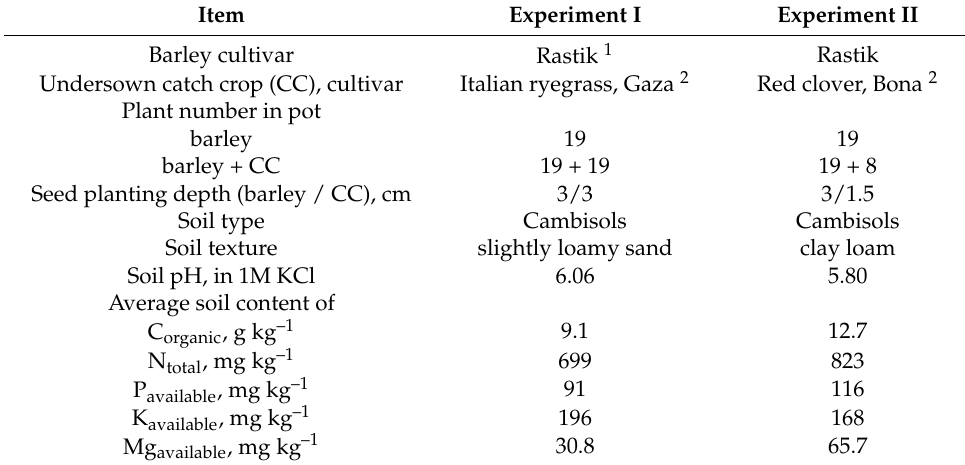
Table 1. Basic data for the